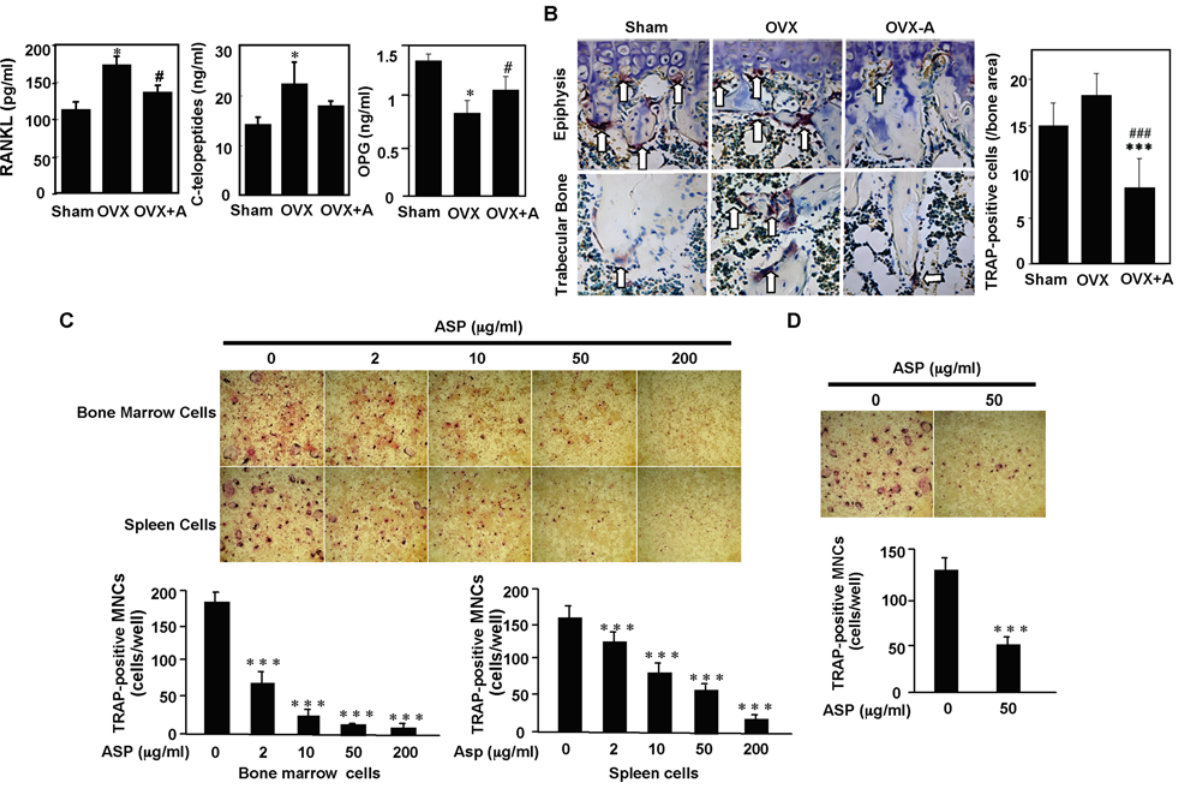
Figure 4. Aspirin treatment inhibits osteoclast activities. ( A ) OVX mice have increased levels of RANKL and type I collagen C-terminal telopeptides and decreased levels of OPG in blood serum as compared to sham mice. Aspirin treated OVX mice (OVX + A) showed a significant decreased levels of RANKL and type I collagen C-terminal telopeptides along with increased levels OPG in blood serum. The graph represents mean 6 SD (n=5; [ P , 0.01 vs. Sham; # P , 0.05 vs. OVX). ( B ) TRAP staining confirmed that OVX mice had increased number of TRAP positive cells in epiphysis and trabecular bone areas of the distal femurs as compared to sham mice. Administration of aspirin for three months resulted in a significant decrease in number of TRAP positive cells (OVX + A) in the epiphysis and trabecular bone areas (n=6; [[[ P , 0.005 vs. Sham; ### P , 0.005 vs. OVX). ( C ) Ex vivo co-culture bone marrow cells or spleen cells with osteoblastic cells revealed that in vitro aspirin treatment inhibits the formation of TRAP-positive multinuclear cells (MNCs) in a dose dependent manner (2–200 m g/ml). The graph represents mean 6 SD (n=5; [[[ P , 0.005 vs. ASP 0 m g/mL). ( D ) RANKL-induced osteoclastogenesis was partially blocked by aspirin treatment at 50 m g/ml as seen a significantly decreased number of TRAP-positive osteoclasts in aspirin treated group (ASP 50). The graph represents mean 6 SD (n=5; [[[ P , 0.005 vs. ASP 0 m